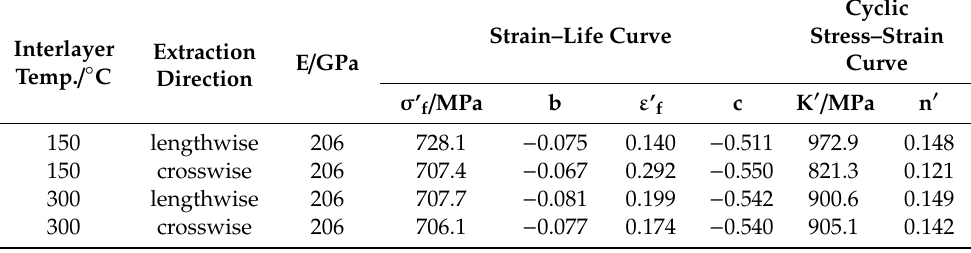
Figure 12. Strain–life curves (logarithmic scale) from strain-controlled tests including the fatigue limits from stress-controlled tests. Table 4. Cyclic material properties.